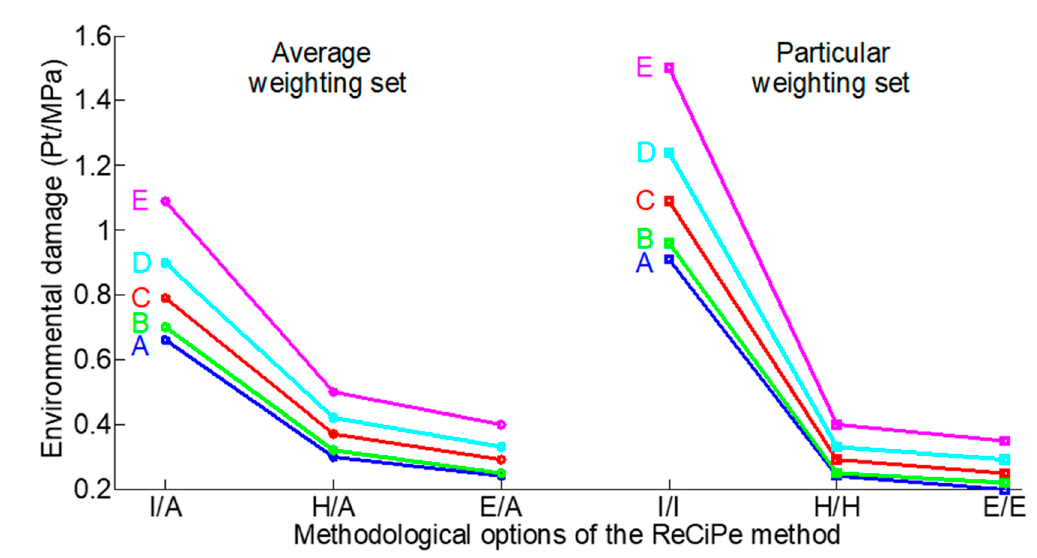
Figure 6. Environmental damage caused by replacing sand with coal bottom ash (CBA): A—CBA0, B—CBA25, C—CBA50, D—CBA75, and E—CBA100. The life-cycle assessments (LCAs) were evaluated via the six ReCiPe2016 single-score methodological options, i.e., individualist/average (I/A) hierarchist/average (H/A), egalitarian/average (E/A), individualist/individualist (I/I), hierarchist/hierarchist (H/H), and egalitarian/egalitarian (E/E). The concrete mixtures designed with a fixed W/C of 0.52; The FU was normalized by dividing the environmental assessment of 1 m 3 of concrete according to the 28-day concrete compressive strength. Table 5. p -values ( p ) of the paired differences in the life-cycle assessment (LCA) production stage of 1 m 3 of concrete normalized according to the 28-day concrete compressive strength for the five concrete alternatives with different percentages of coal bottom ash (CBA) replacing sand. The concrete mixtures were designed with a fixed W/C of 0.52.